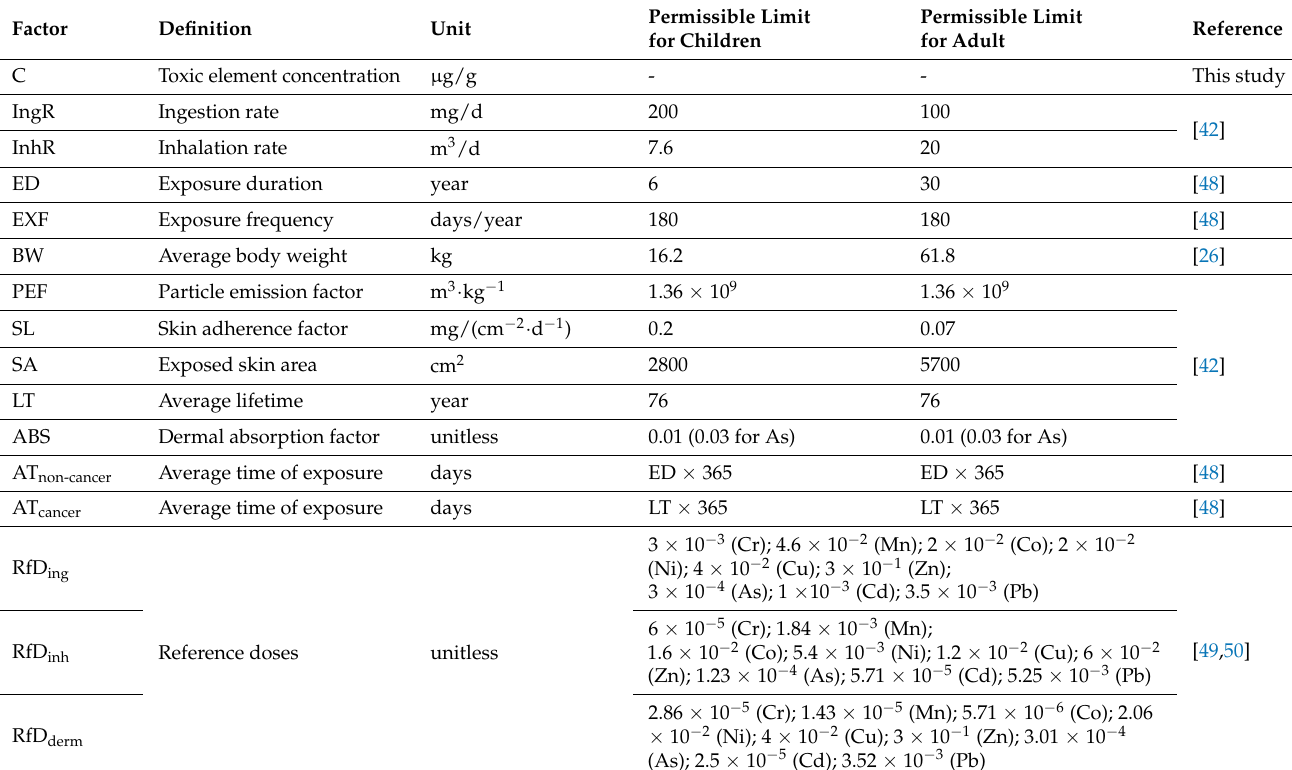
Table 1. Definitions and values of parameters used in the human health risk